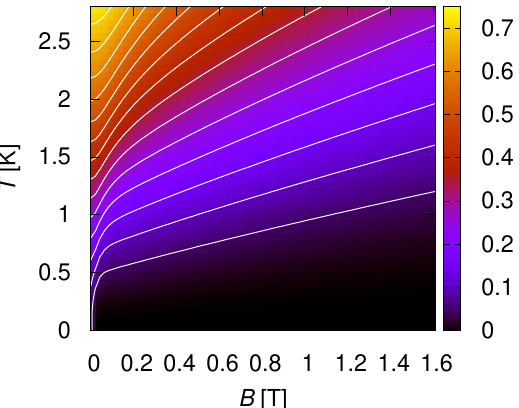
Figure 14. Entropy S per spin calculated by ED for an isolated chain with N = 10 spins and J = 2.8 K, D = 0.36